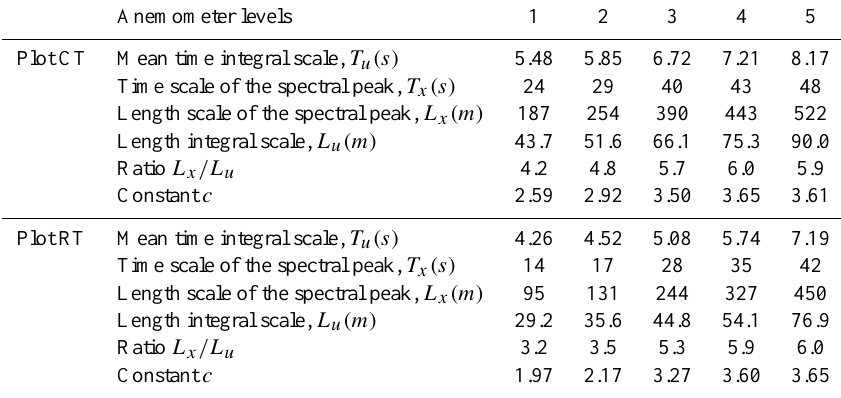
Table 4. Ratio of the spectral energy-containing scale to the length integral scale and the Von Karman spectrum’s constant c , according to the plots and the anemometer levels. Average within the daytime interval 07:00–17:00LT, 25 July 1997